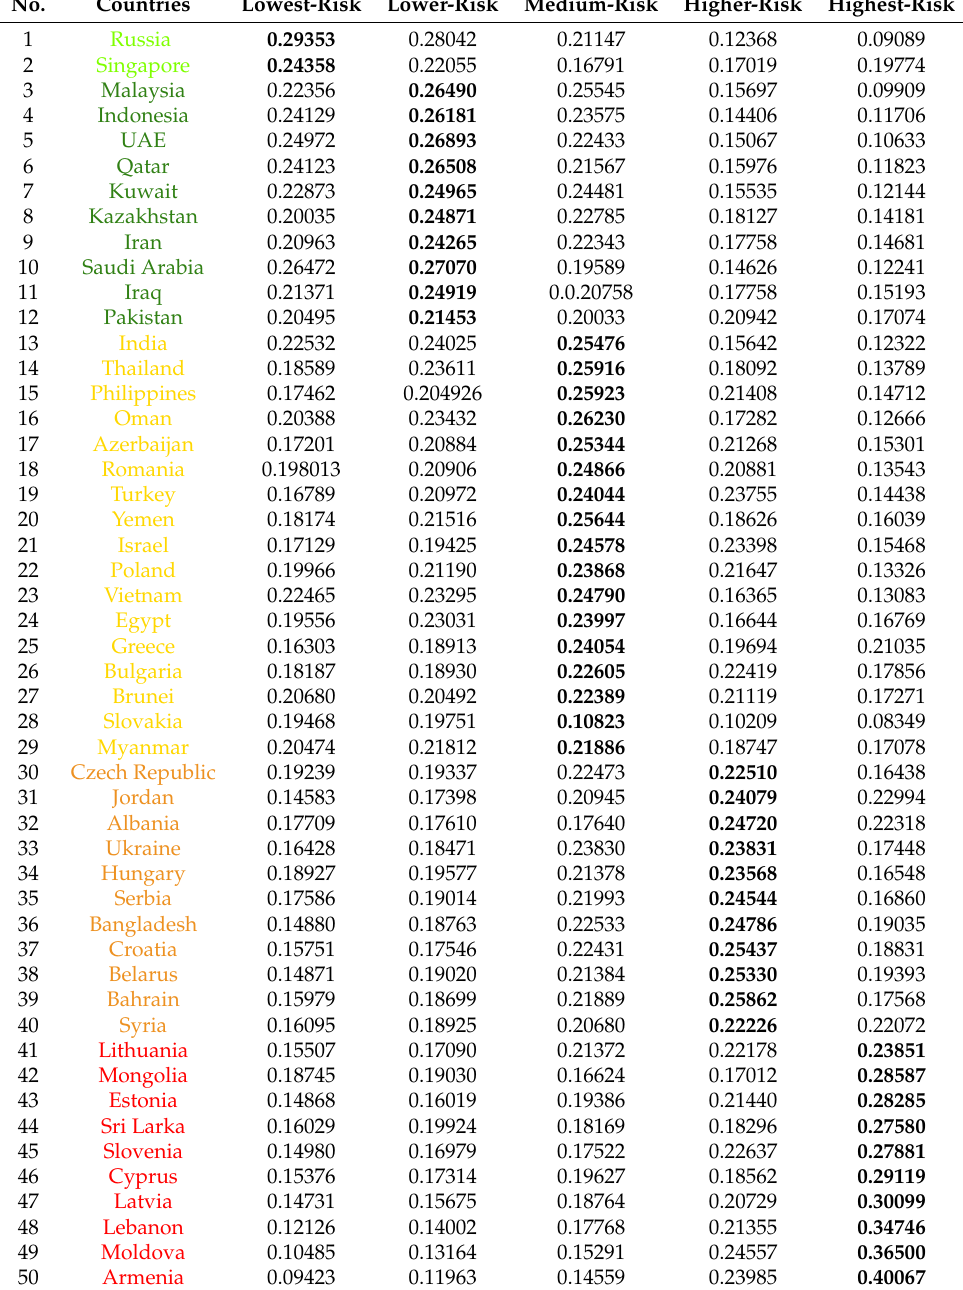
Table 4. Evaluation results of the energy investment risk of the nation’s along China’s “Belt & Road Initiative” based on the statistics from 2013 to 2019. The score in bold is the highest of a raw score which, correspondingly, denotes the risk level a nation belongs